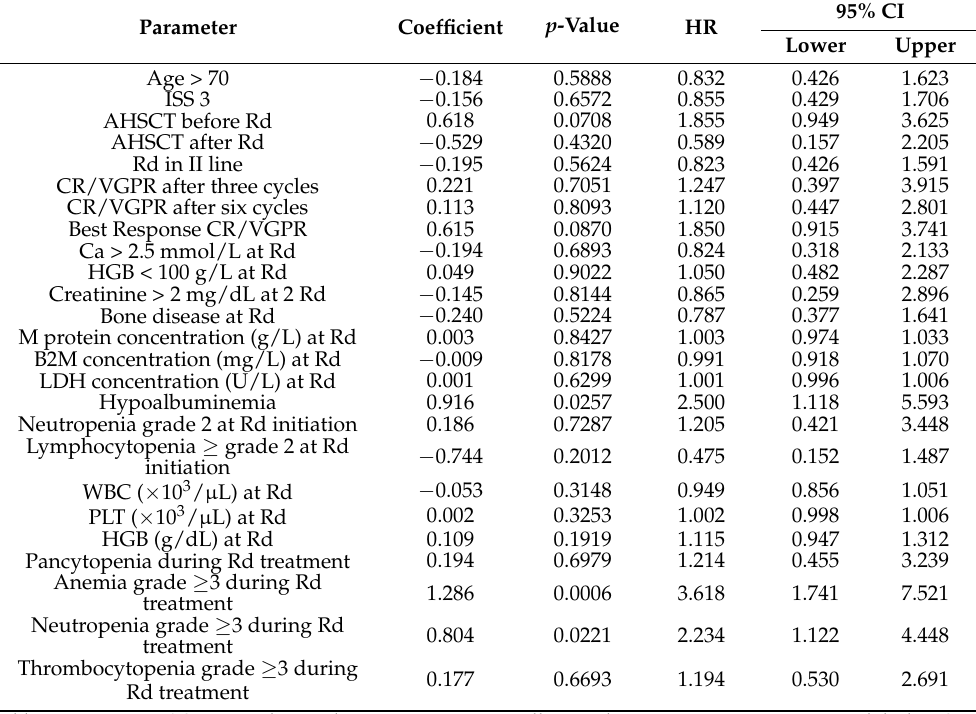
Table 3. Univariate logistic regression for infection during Rd treatment.